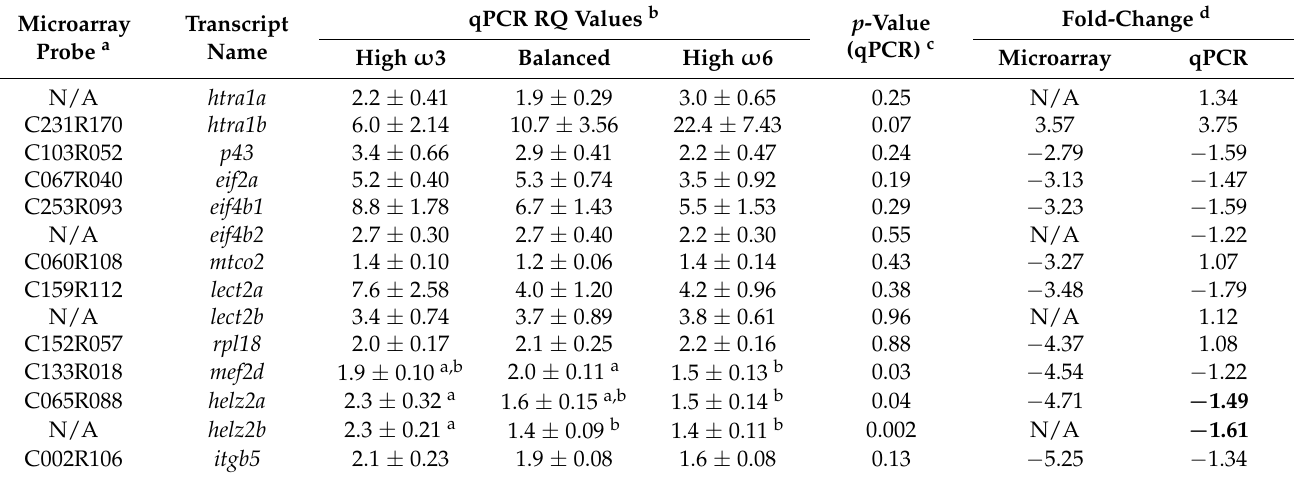
Table 3. Hepatic qPCR analysis of microarray-identified transcripts, and comparison between the microarray and qPCR results. Microarray